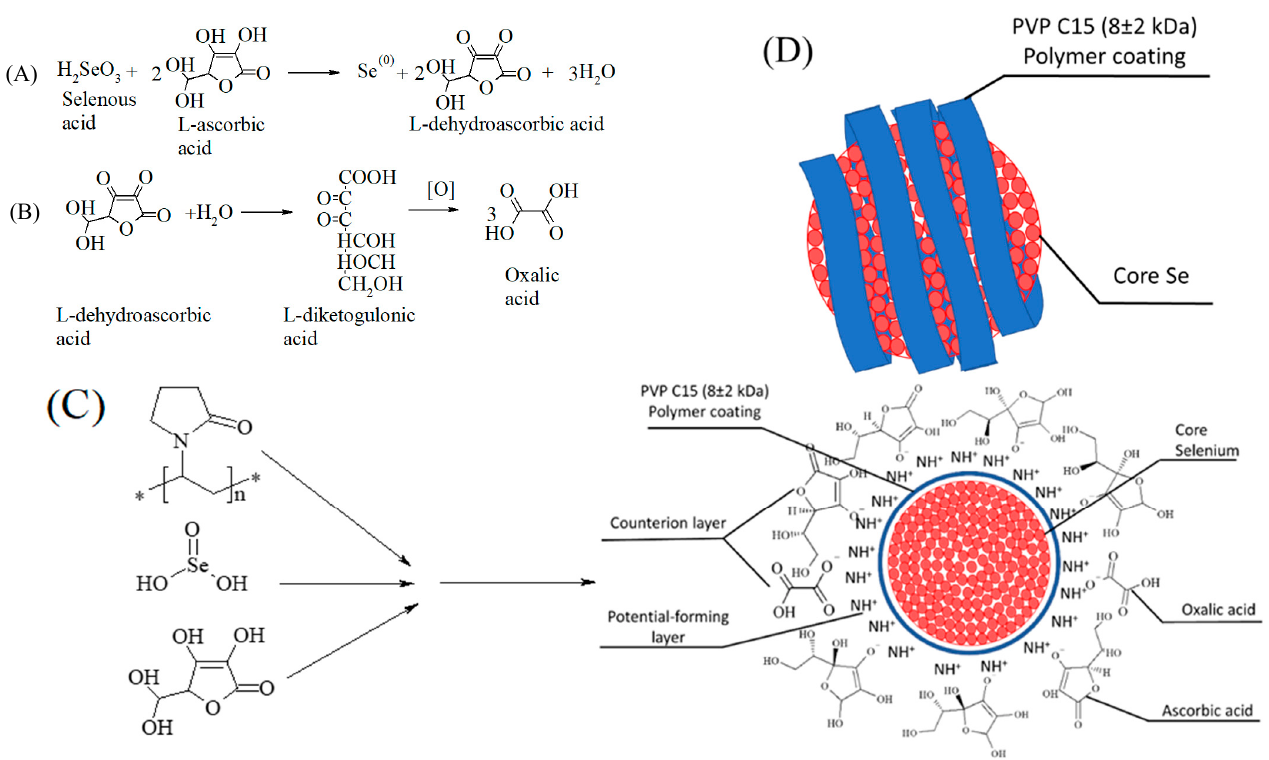
Figure 1. Synthesis of preparation of selenium nanoparticles stabilized with PVP C15 (8 ± 2 kDa) and ascorbic acid: ( A ) reaction of reduction of selenic acid with ascorbic acid to elemental selenium; ( B ) transformation of dehydroascorbic acid into oxalic acid; ( C ) structure of the double electric layer of the preparation of selenium nanoparticles stabilized with PVP C15 (8 ± 2 kDa) and ascorbic acid; ( D ) schematic image of the polymer stabilization of selenium